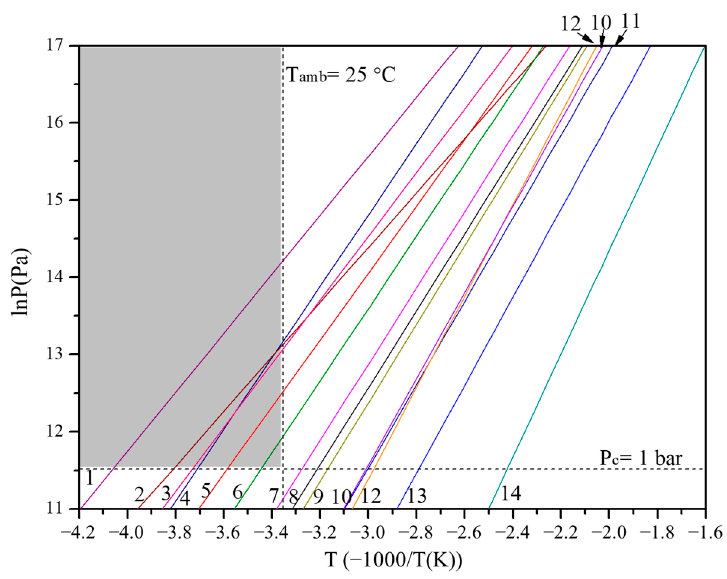
Figure 3. Clausius–Clapeyron diagram of typical metal halide ammines in equilibrium reaction with ammonia.